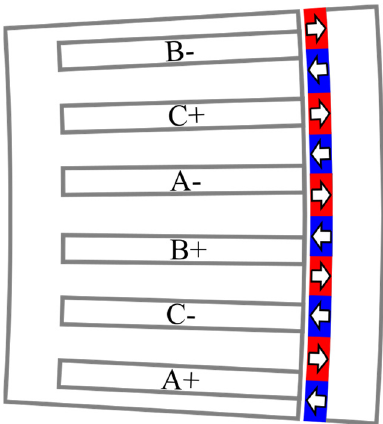
Figure 6. Two-dimensional cross section of a 3 MW outer-rotor Vernier machine [56].